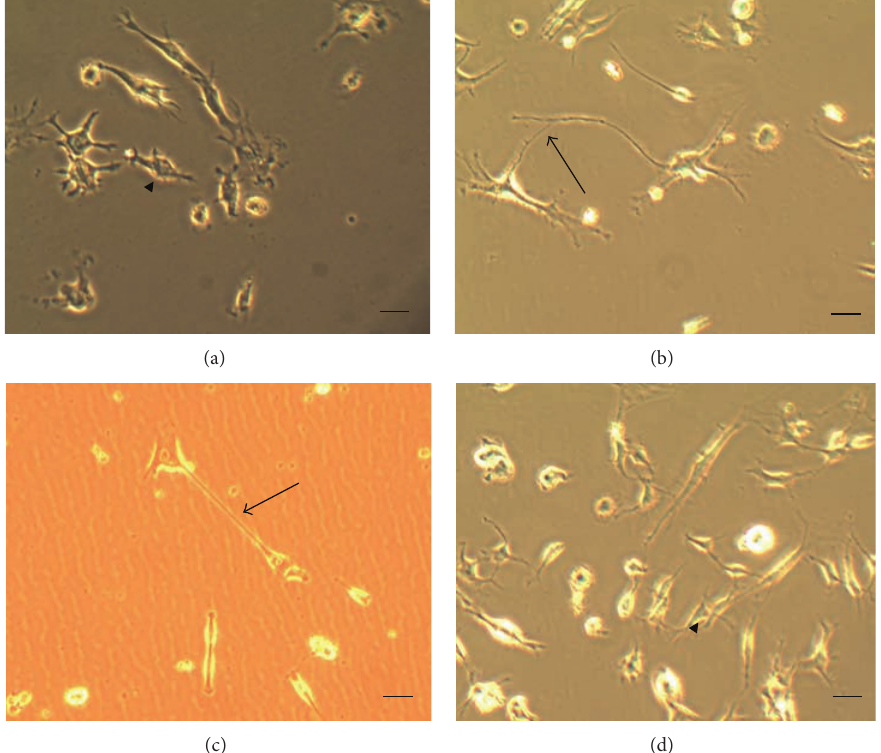
Figure 2: Morphological appearance of mesenchymal cells. (a) Bipolar cell and (b) cell with secondary prolongment, Group 2; (c) cell with primary prolongment and (d) tripolar cell, Group 4 (10x). Scale: 100 𝜇